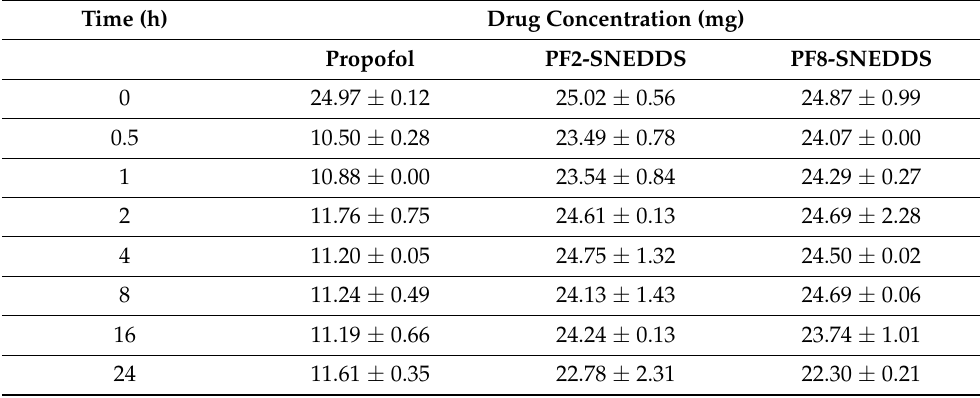
Table 5. Effect of dynamic dispersion on the solubilization profiles of propofol (initially 25 mg of propofol was dissolved in water). Data are expressed as mean ± SD, n =